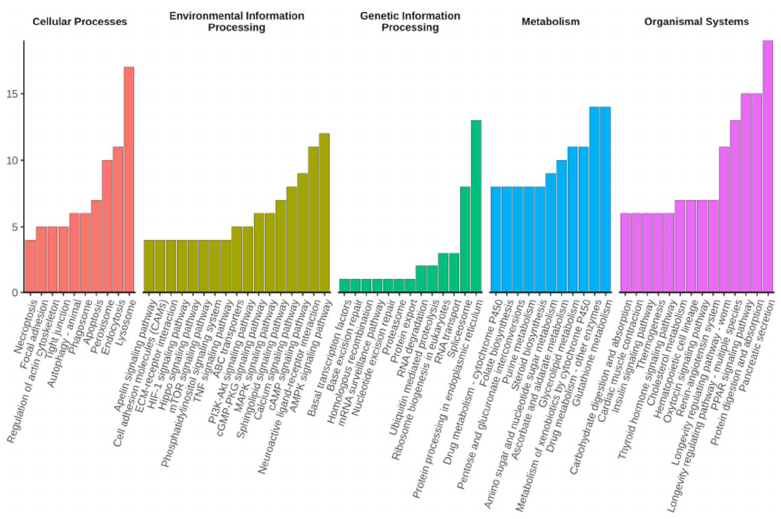
Figure 3. Kyoto Encyclopaedia of Genes and Genomes (KEGG) pathways that were significantly enriched in shared DEGs upon diapause termination. KEGG pathways with the top 10 number of DEGs (with ties) within one KEGG category are shown. The y -axis indicates the number of DEGs.